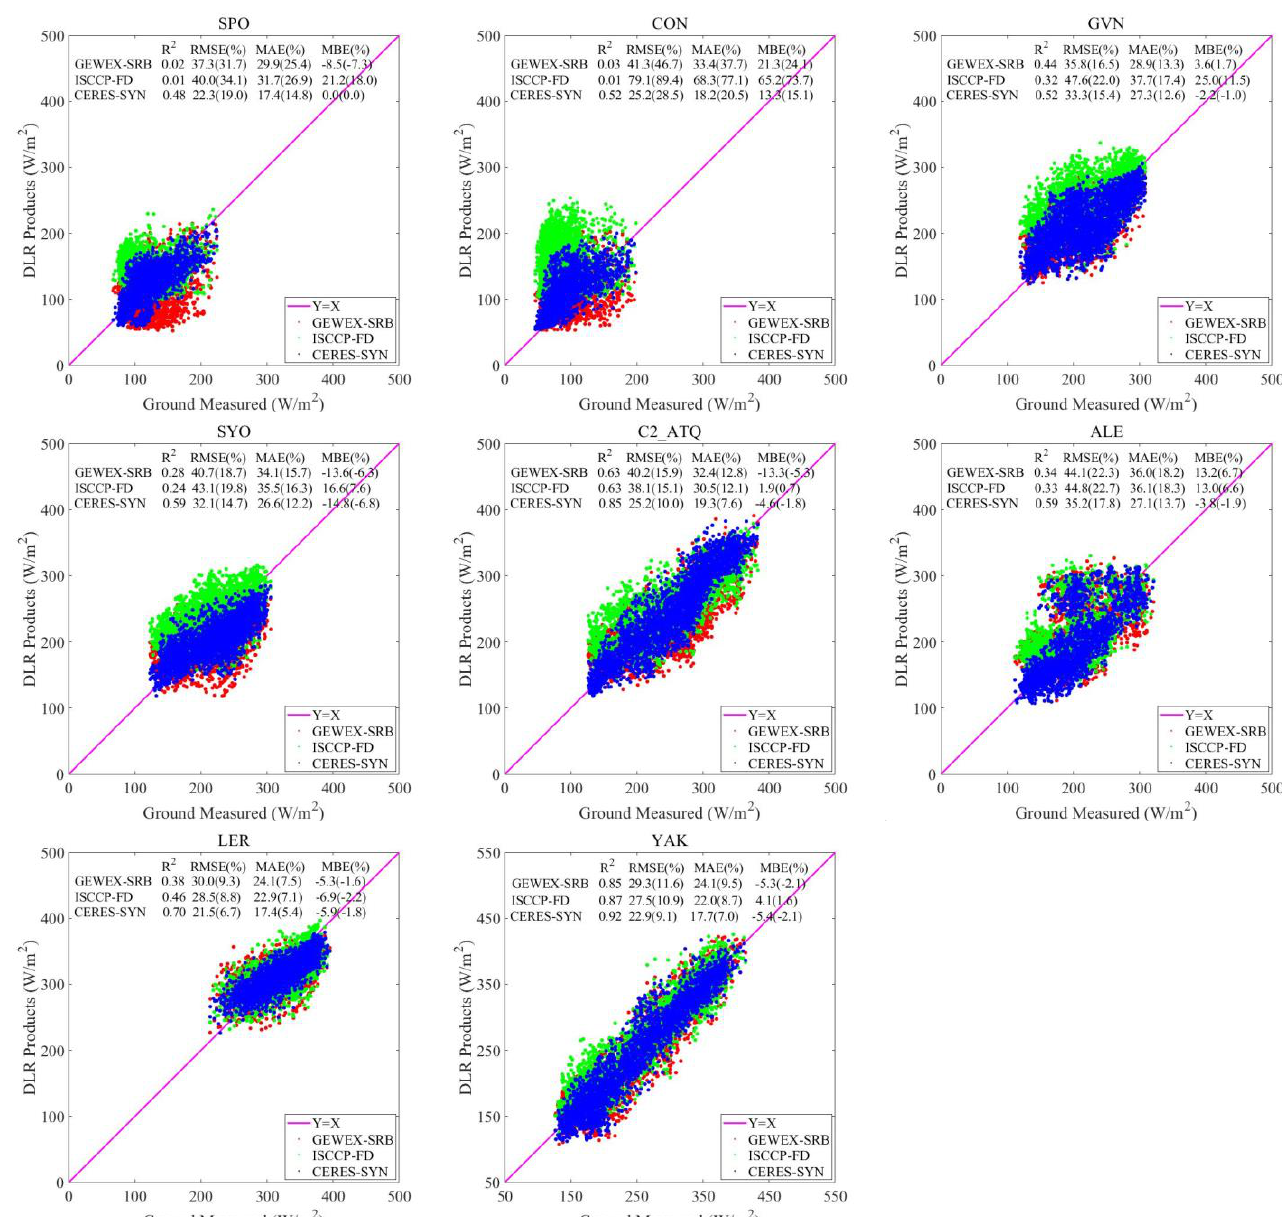
Figure 2. Comparison between ground measurements and 3 h DLR products at 8 sites. The 6 sites with RMSE larger than 40 W/m 2 for ISCCP-FD or GEWEX-SRB, and the 2 sites (LER and YAK) with RMSE smaller than 30 W/m 2 for all the three products are displayed.